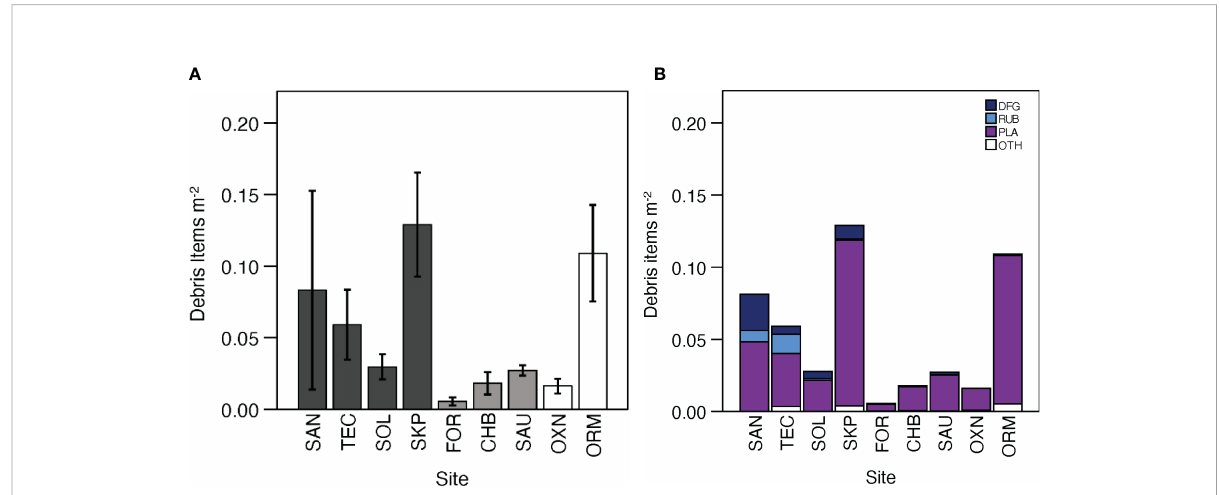
FIGURE 2 The initial density of marine debris (A) , represented as the number of debris items per m 2 (mean ± S.E.) collected on three transects per site during the initial collection at Santa Rosa Island (SAN, TEC, SOL, SKP - dark gray), Santa Cruz Island (FOR, CHB, SAU - light gray), and Ventura County mainland sites (OXN, ORM - white). Composition (B) of initial density of marine debris items represented as the mean number of debris items per m 2 collected during the initial collection at each site. Items were classi fi ed as Discarded Fishing Gear (DFG), Rubber (RUB), Other (OTH), and Plastics